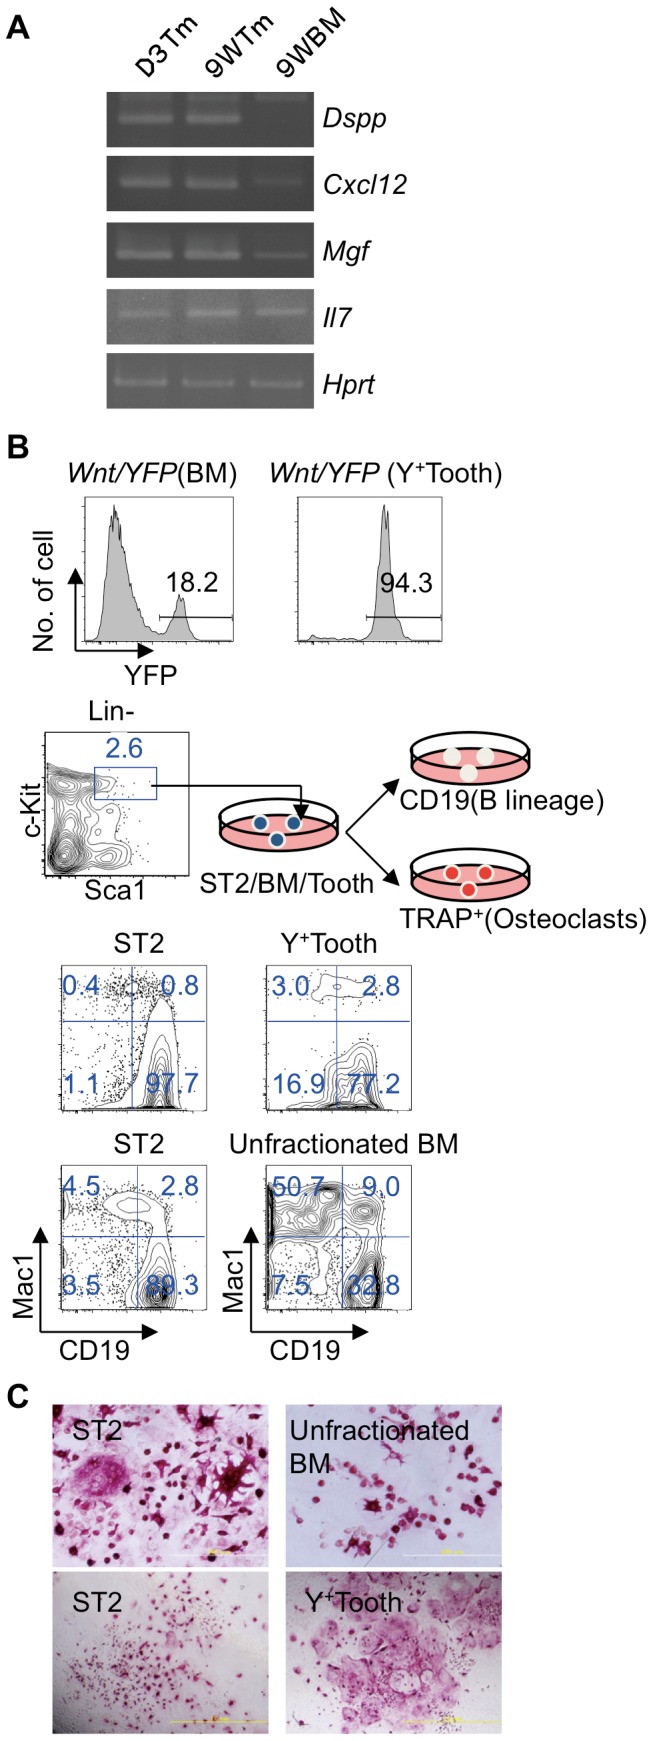
NC-derived dental mesenchymal cells support B lymphopoiesis and osteoclastogenesis.(A) Expression of genes encoding hematopoietic factors on CD45− and Ter119− BM mesenchymal cells and dental mesenchymal cells. RT-PCR was performed using RNA from these cells. Hypoxanthine guanidine phosphoribosyl transferase (Hprt) was the positive control. D3Tm, dental mesenchymal cells from 3-day-old mice; 9WTm, dental mesenchymal cells from 9-week-old mice; 9WBM, CD45− and Ter119− BM mesenchymal cells from 9-week-old mice. (B) Induction of B lineage cells. Unfractionated BM and purified YFP+ dental mesenchymal cells (Y+ Tooth) from 3-day-old Wnt1-Cre/YFP mice were cultured. Percentages of YFP+ cells in the CD45− and Ter119− fractions after 2 weeks' culture (upper panels). BM-derived 200 KSL cells were then cultured on purified YFP+ dental mesenchymal cells (Y+ Tooth) or unfractionated BM mesenchymal cells in the presence of rmIL-7. Mac1 and CD19 were used as Myeloid cell lineage and B cell lineage markers. (C) Osteoclast induction. One hundred KSL cells were cultured on unfractionated BM and YFP+ dental mesenchymal cells (Y+ Tooth) prepared from the same mice in the presence of 1α,25(OH)2D3, and DEX. TRAP staining was performed to detect osteoclasts. ST2 stromal cells were used as the positive control to support the differentiation of B lymphocytes and osteoclasts. Each experiment with BM or dental mesenchyme is shown with ST2 as the control (B, C). Each experiment was repeated twice and one representative experiment is presented. Scale bars, 200 µm.